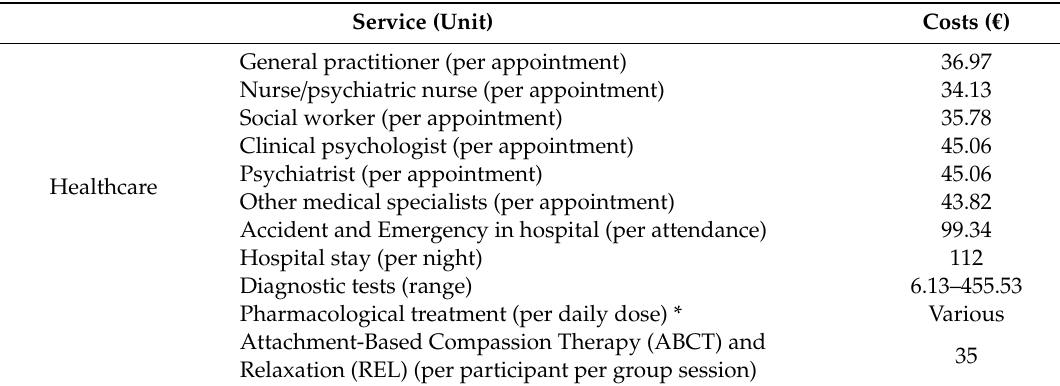
Table 1. Unit costs used in the calculations of direct costs (financial year 2016; values in €